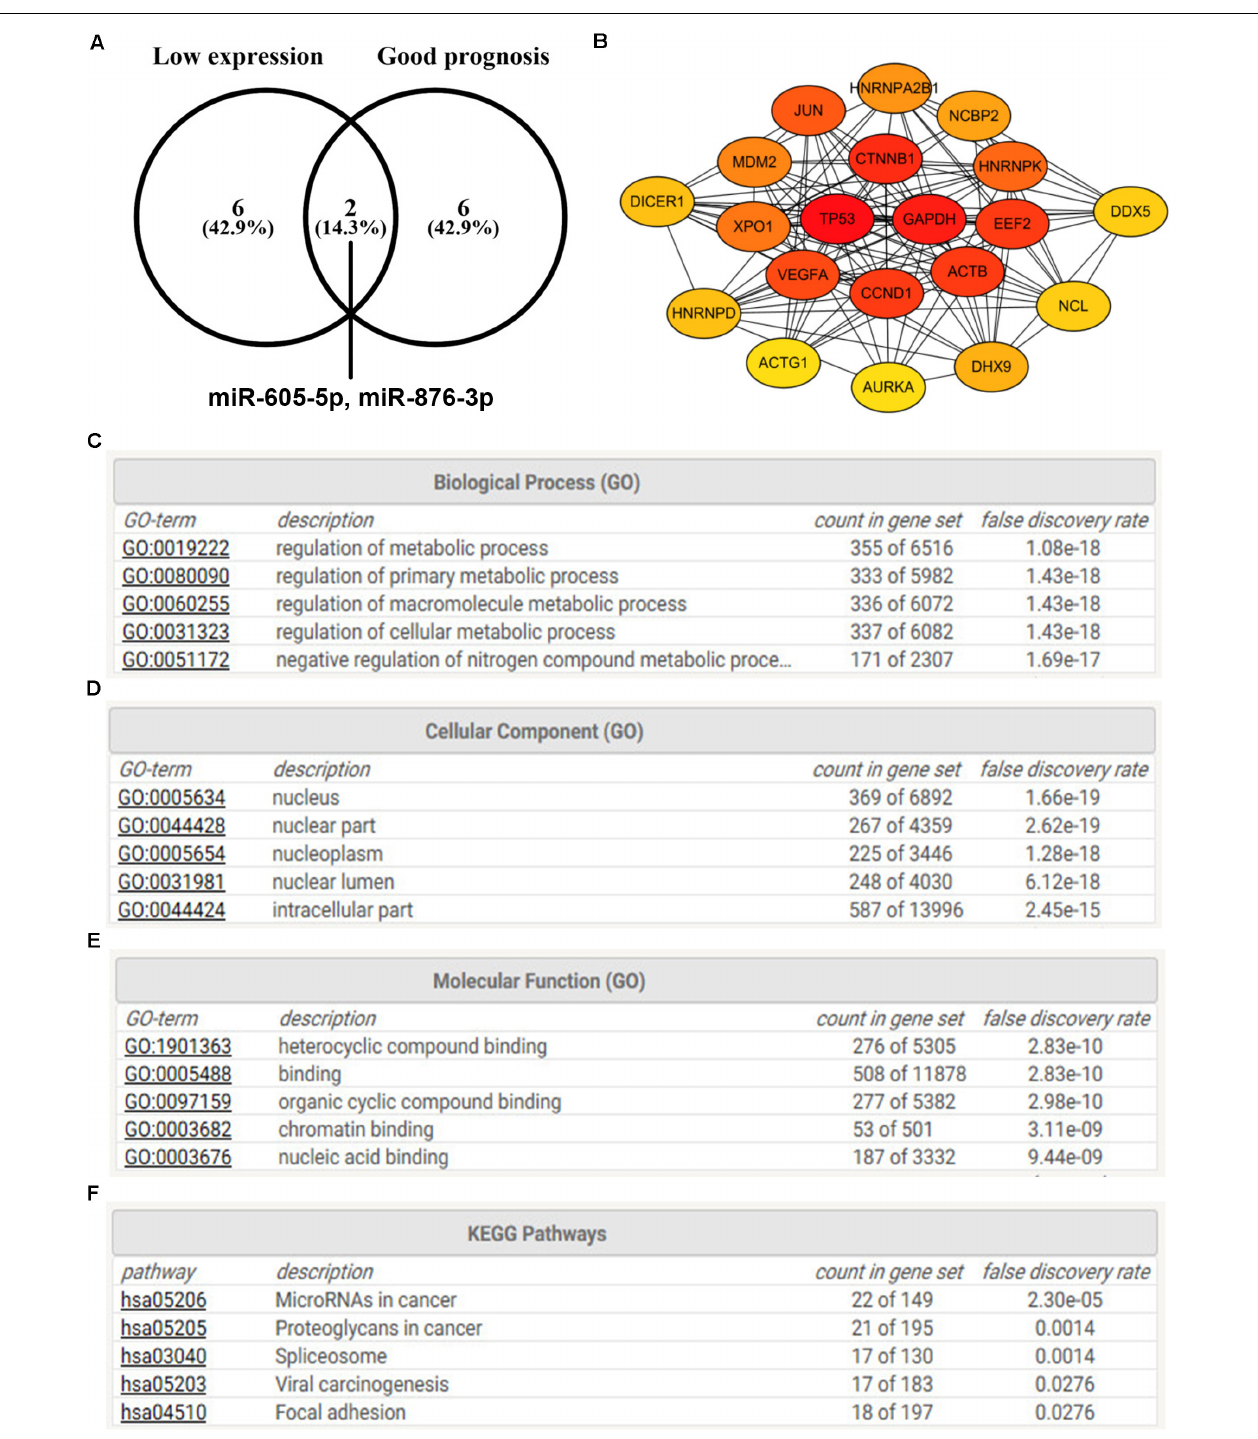
FIGURE 6 | The protein–protein interaction (PPI), Gene Ontology (GO) functional annotation, and KEGG pathway enrichment analyses for target genes of miR-605-5p and miR-876-3p. (A) Identification of miR-605-5p and miR-876-3p as two most potential binding miRNAs of candidate circRNAs. (B) The PPI analysis for target genes of miR-605-5p and miR-876-3p. (C) The top 5 GO biological process items for target genes of miR-605-5p and miR-876-3p. (D) The top 5 GO cellular component items for target genes of miR-605-5p and miR-876-3p. (E) The top 5 GO molecular function items for target genes of miR-605-5p and miR-876-3p. (F) The top 5 KEGG pathways for target genes of miR-605-5p and miR-876-3p.